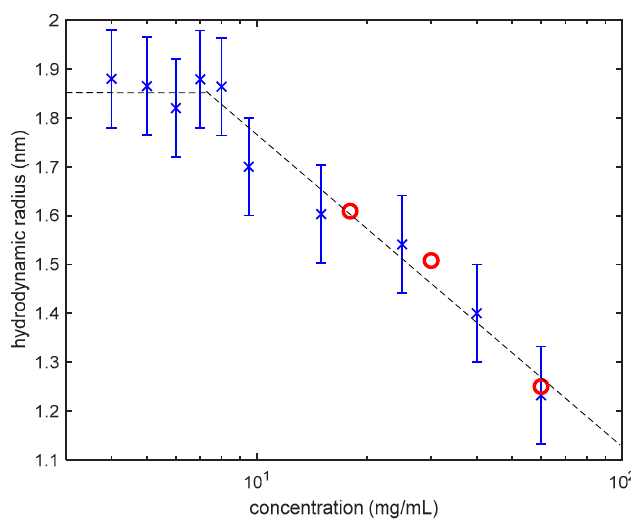
Figure 1. Apparent hydrodynamic radius of lysozyme monomers, obtained by DLS, as a function of concentration at 25 ◦ C [10]. In dilute solutions ( < 10 mg / mL) it represents the actual size of the lysozyme monomers. Upon the increase of concentration, the apparent radius (blue crosses) sharply decreases because of the interactions between lysozyme molecules. Red circles are the results of our new measurements.